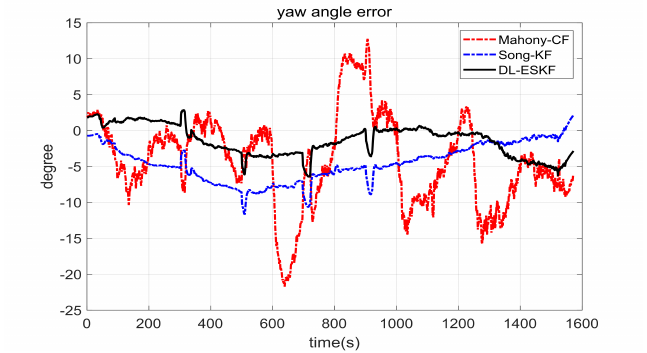
Figure 14. Yaw angle error under dynamic